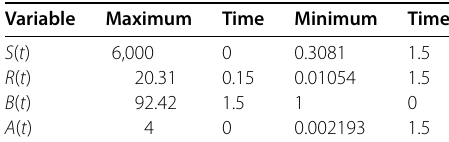
Table 3 Extremum values of